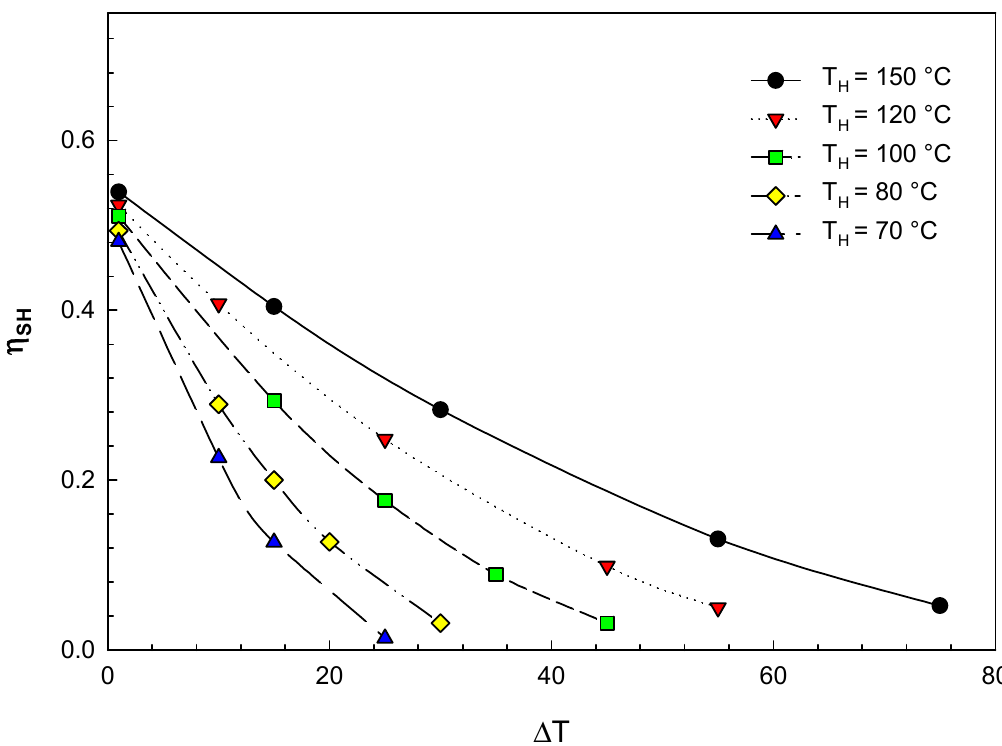
Figure 4. Theoretical values of the correction factor for “sensible heat sources” η SH in relation to the “hot and cold” temperatures, T H and T C .